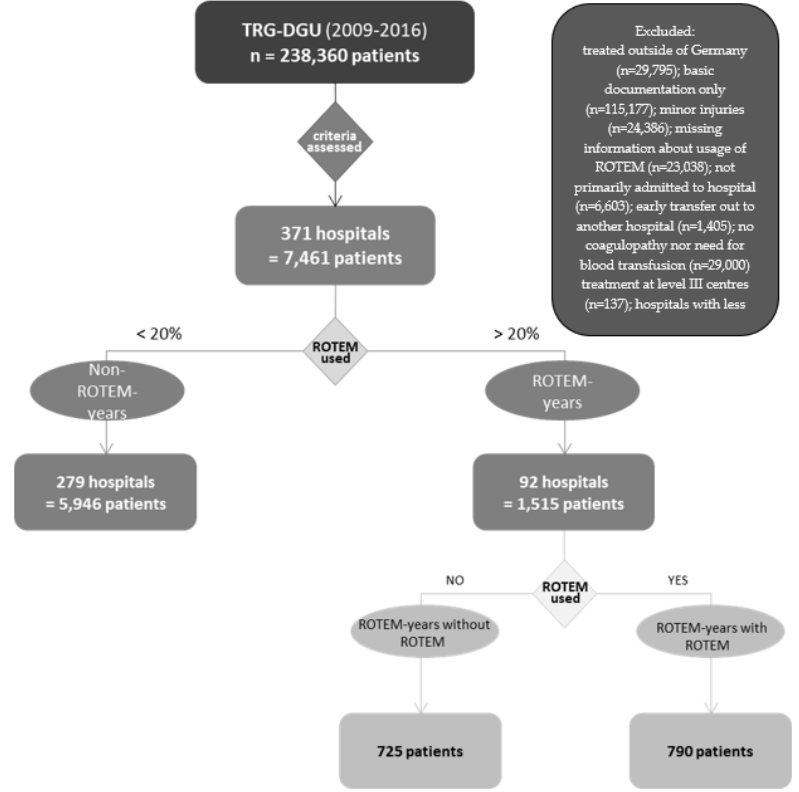
Figure 2. Segmentation of groups.